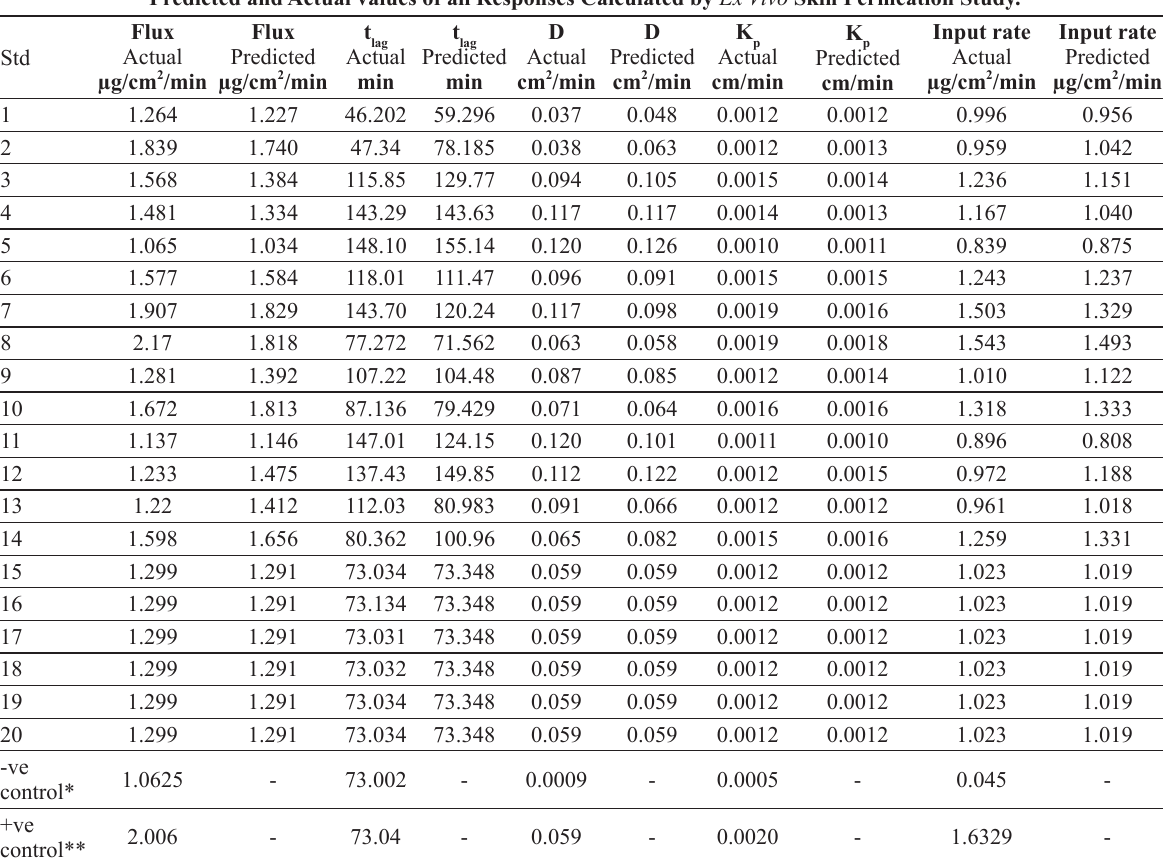
Predicted and Actual values of all Responses Calculated by Ex Vivo Skin Permeation Study.